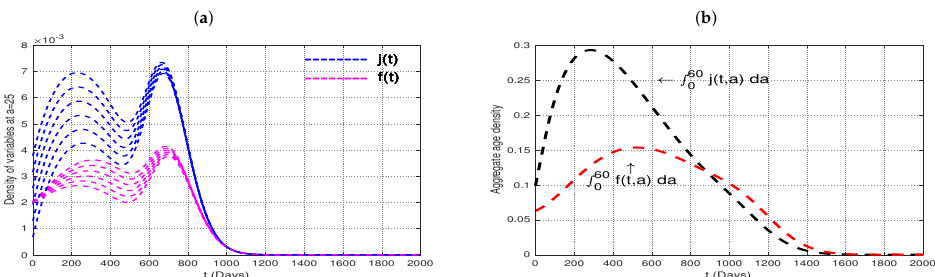
( t , a ) ; ( c ) the distribution of 1